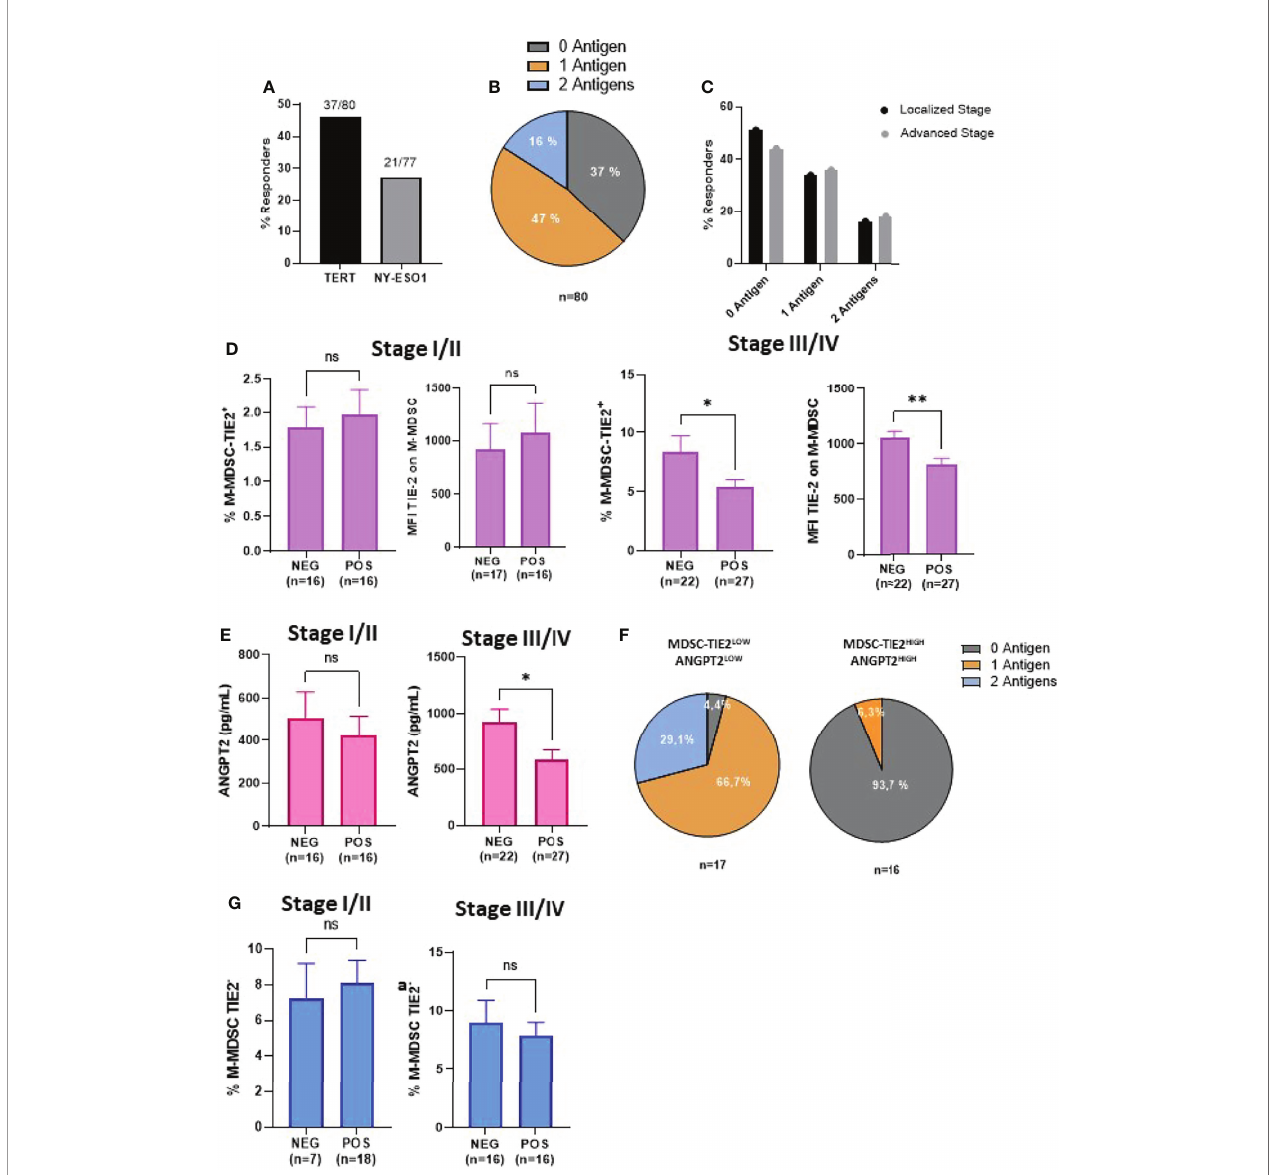
FIGURE 2 | Correlation between TIE-2 + M-MDSC/ANGPT2 and antitumor-speci fi c T-cell responses in melanoma patients. (A) Frequency of patients exhibiting spontaneous T-cell responses against TERT (37/80) or NY-ESO1 (21/77) antigens by IFN- g ELISpot assay. (B) Distribution of patients according to their antitumor responding responses against 0, 1, or 2 antigens (n = 80). (C) Responders ’ frequency to 0, 1, or 2 antigens between localized or advanced stages. (D) TIE-2 + M- MDSC percentage and TIE-2 MFI expression according to antitumor T-cell response negative (NEG) or positive (POS) in localized stage (I – II) (left) and in advanced stage (III – IV) (right) (Student ’ s t-test, * p < 0.1). (E) ANGPT2 concentration according to antitumor T-cell response negative (NEG) or positive (POS) in localized stage (I – II) (left) and in advanced stage (III – IV) (right) (Student ’ s t-test, *p < 0.1, **p < 0.01). (F) Distribution of antitumor T-cell responses in TIE-2 high M-MDSCs, ANGPT2 high (n = 16) vs TIE-2 low M-MDSCs, and ANGPT2 low (n = 17). (G) TIE-2 neg M-MDSC percentage according to antitumor T-cell response negative (NEG) or positive (POS) in localized stage (I – II) (left) and in advanced stage (III – IV) (right) (Student ’ s t-test, *p < 0.1). ns, no